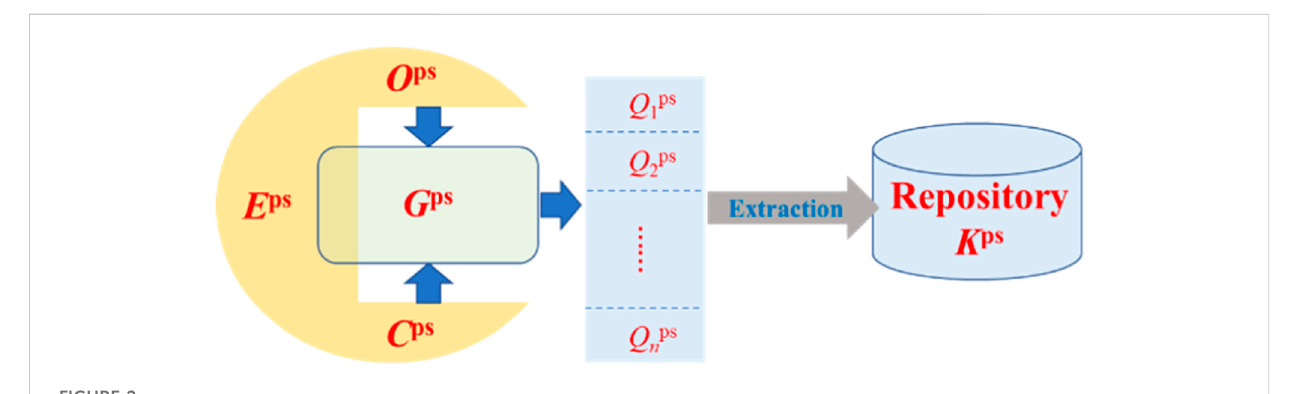
FIGURE 2 The architecture of AIDLM in power